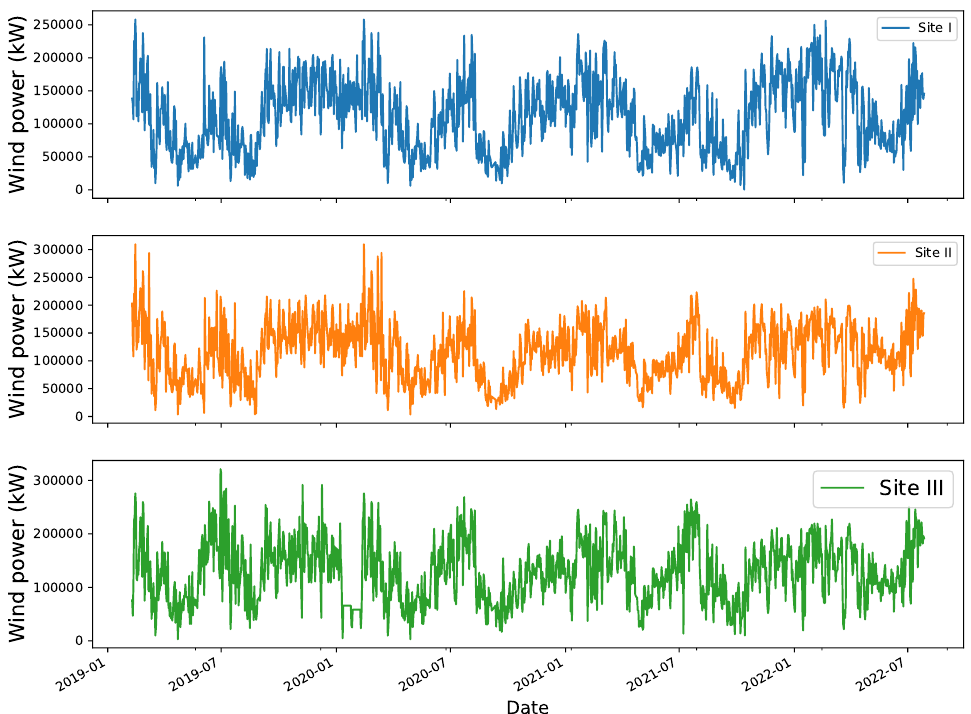
Figure 4. Daily wind generation capacity by three wind farms Sites. The autocorrelation value for wind power generation at Site I (as shown in Figure 5) exhibits high peaks at lag 1 and lag 2, then decreases gradually as the lag value increases up to 33 days. The autocorrelation plot confirms that the previous 30 lags of wind power values are highly correlated with each other and the trend is statistically significant in the subsequent series.